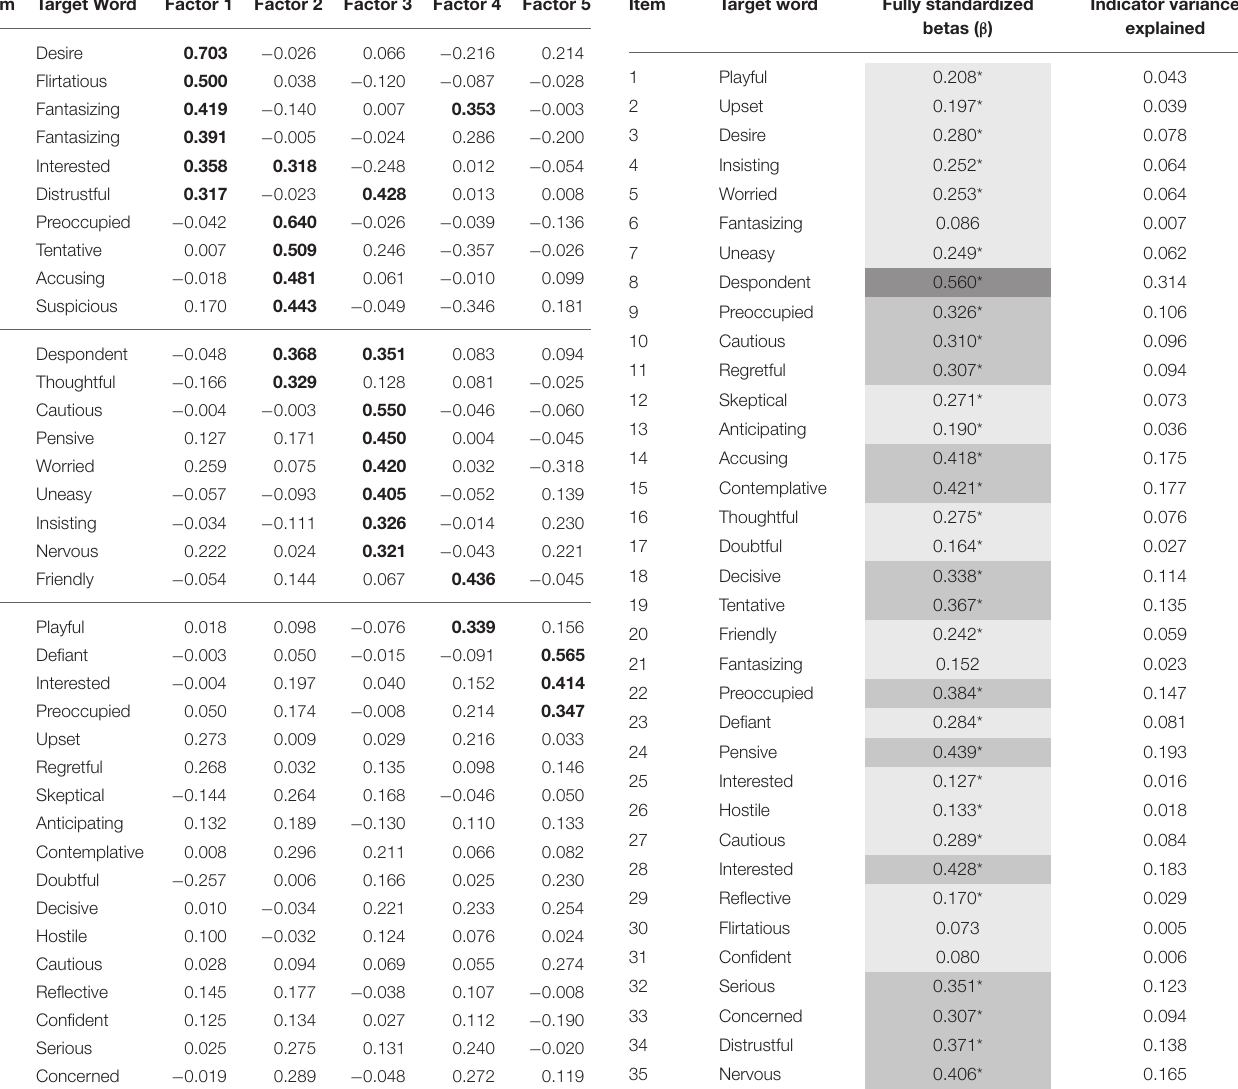
TABLE 4 | Study 1: confirmatory factor analysis results, including factor loadings ( β ) and variance explained, for a 1-factor solution.